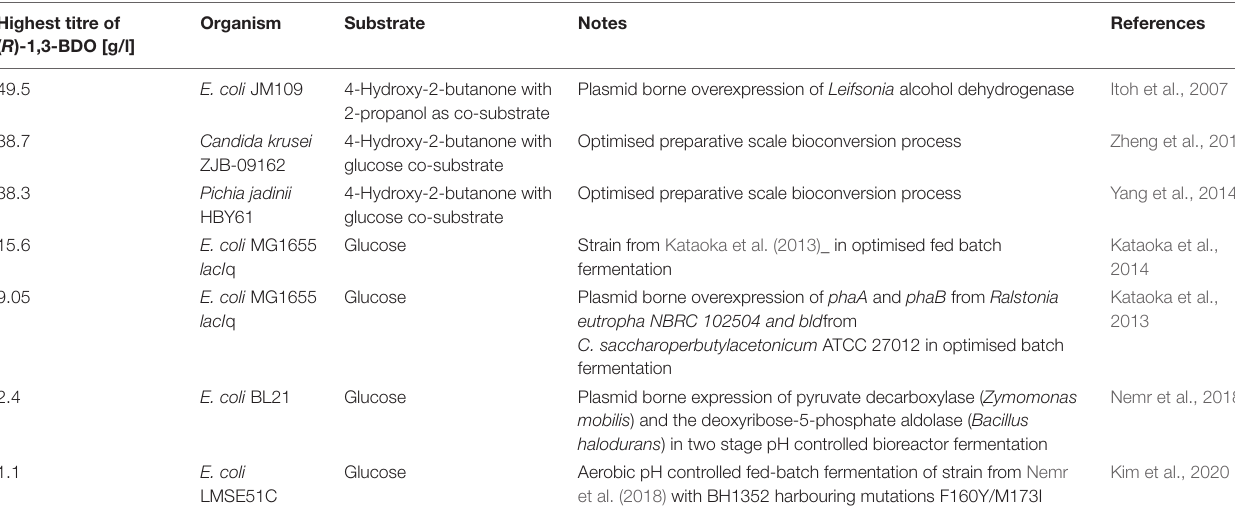
TABLE 1 | Summary of literature to date presenting microbial production of ( R )-1,3-BDO from different substrates. Highest titre of ( R )-1,3-BDO